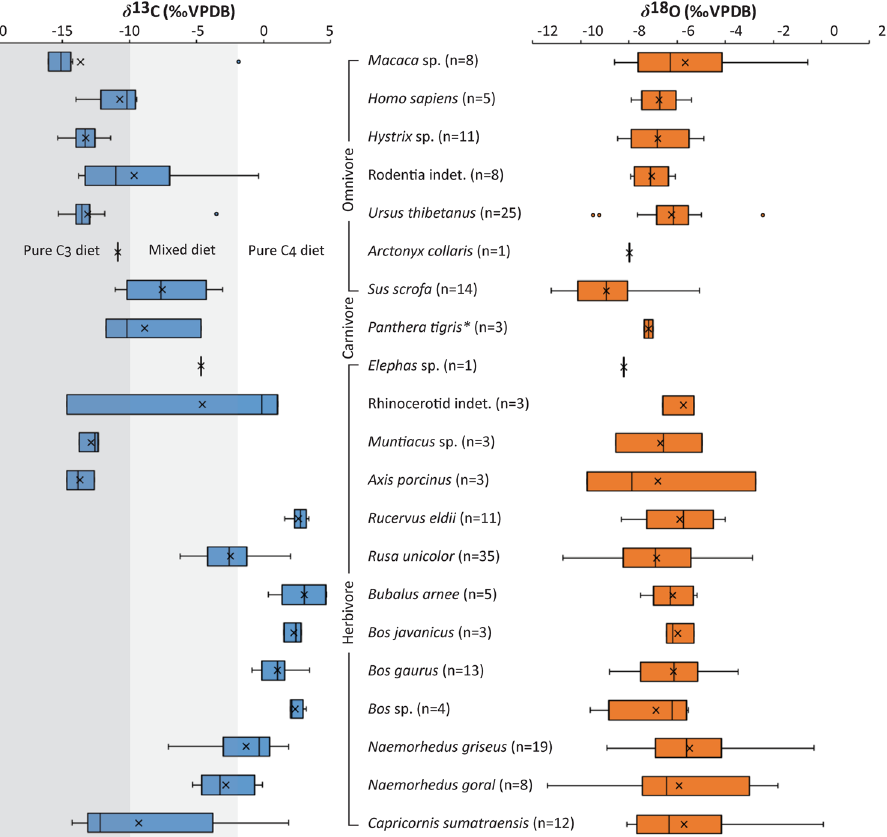
Figure 3. Box plots of bulk δ 13 C (blue) and δ 18 O (orange) values of human and faunal tooth enamel from the late Pleistocene of Tham Lod Rockshelter in highland Pang Mapha, northwestern Thailand. Asterisks (*) indicate carnivorous mammals with adjusted δ 13 C values of + 1.3‰ according to 42,43